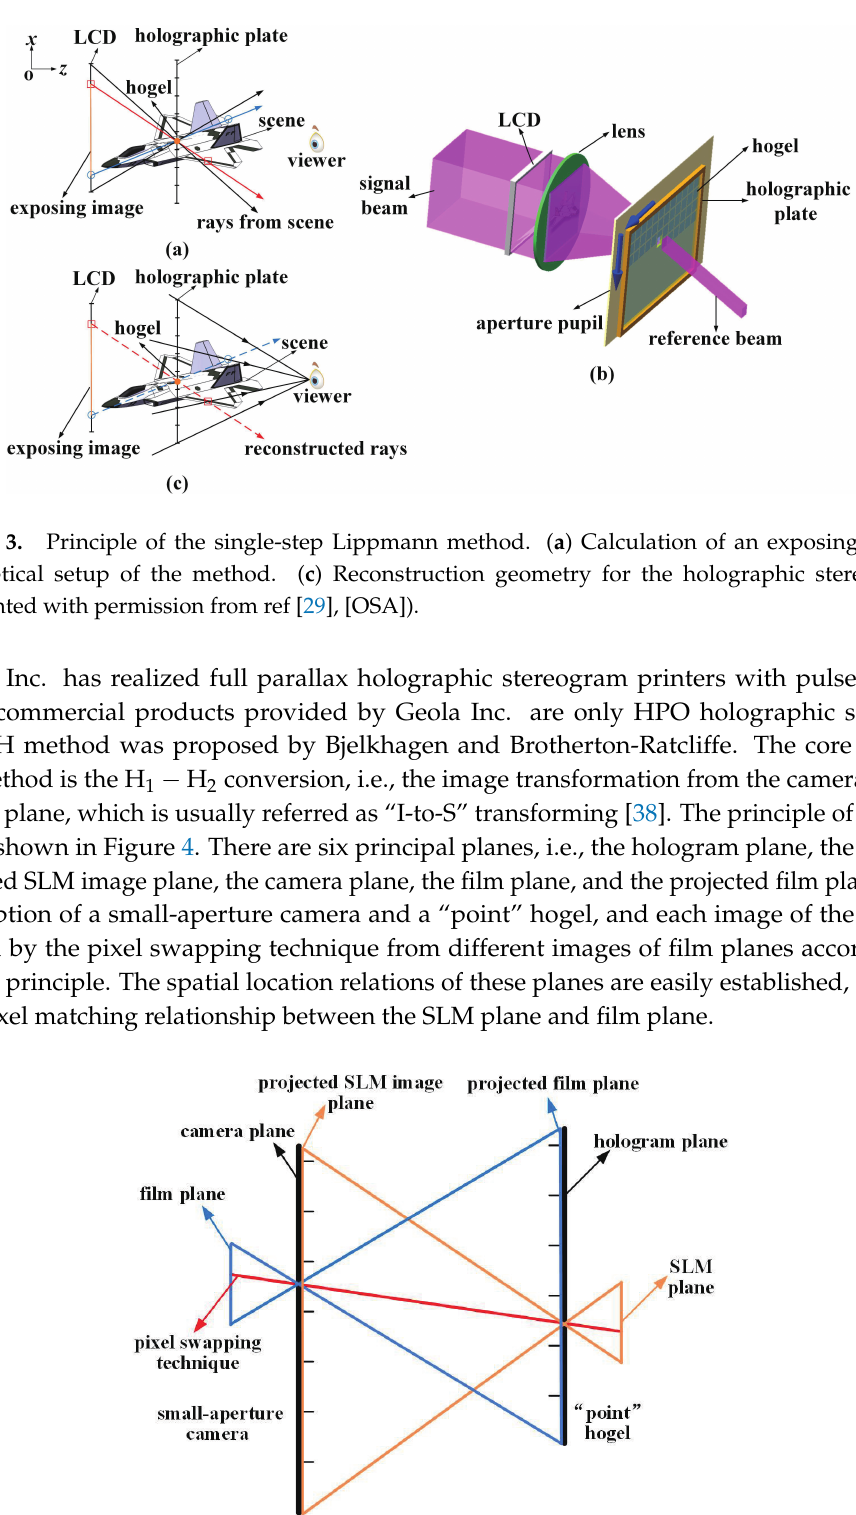
Figure 4. Principle of the direct-write digital holography (DWDH)